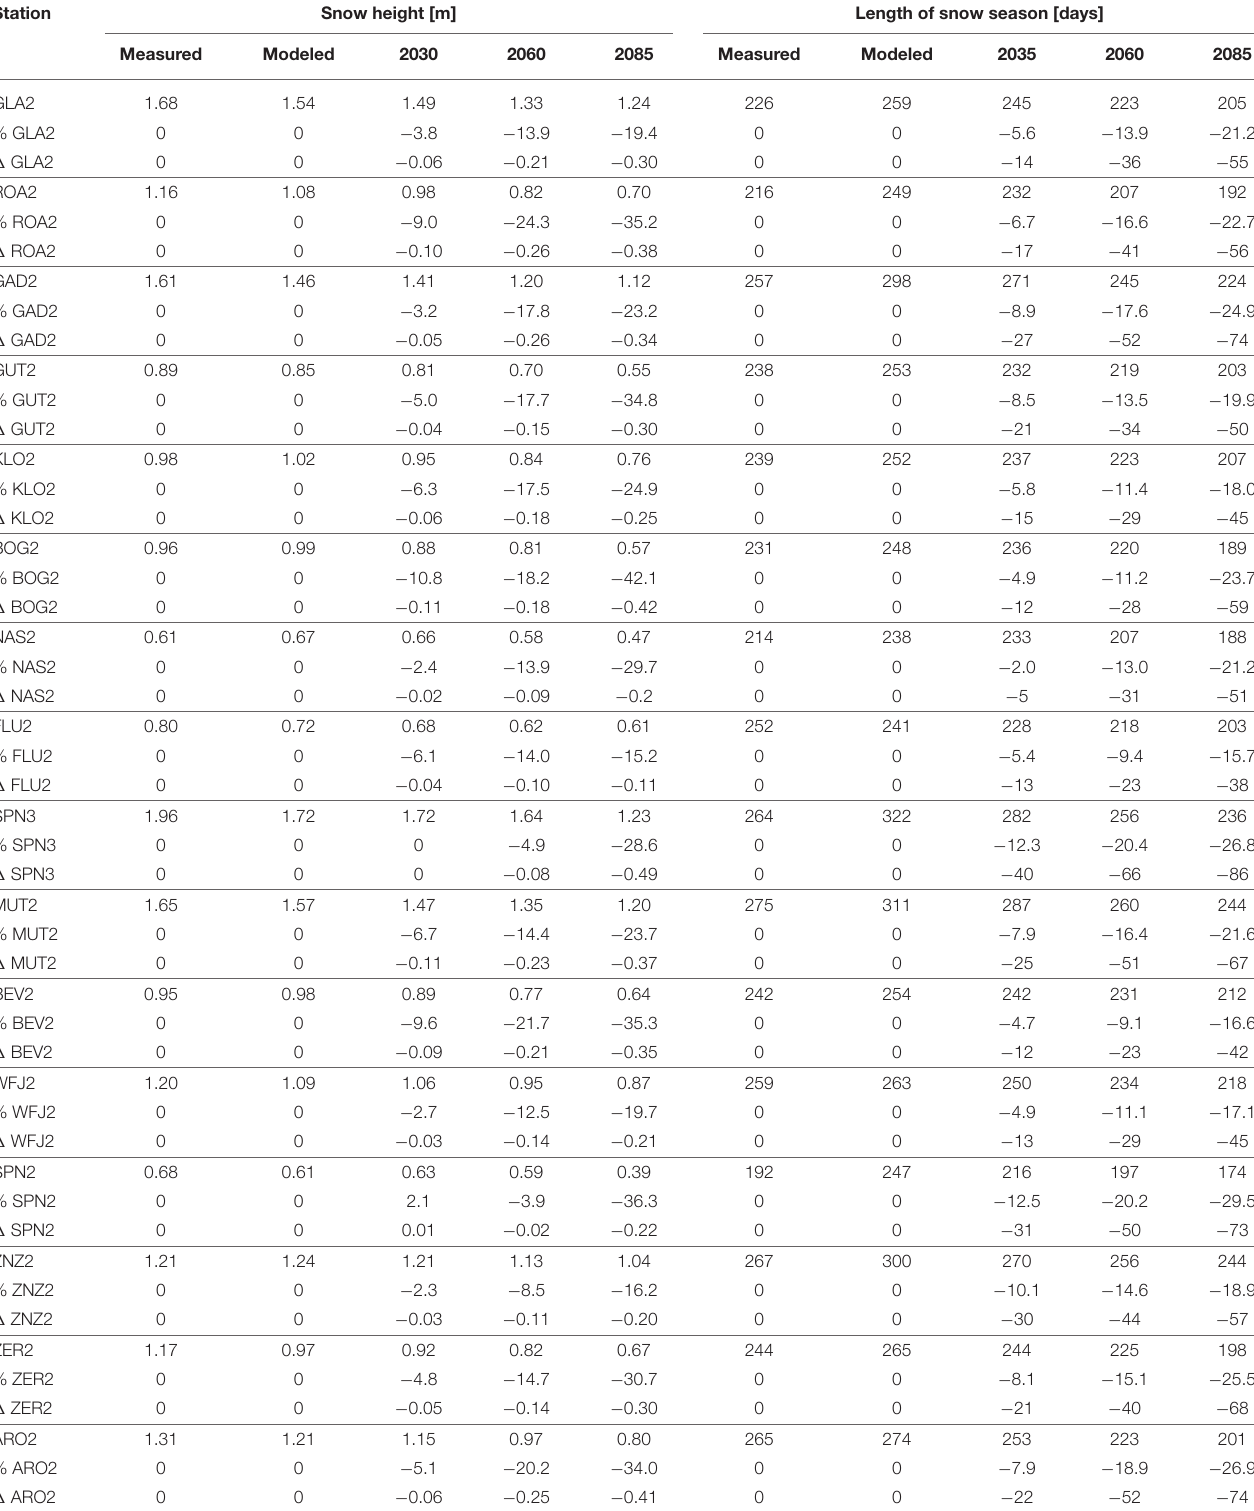
TABLE 3 | Mean snow height (HS), for all days with snow height > 0.1 m in meters and length of snow season in days for the reference period as well as for the three future periods and decrease in percentage of total snow height and length of snow season.